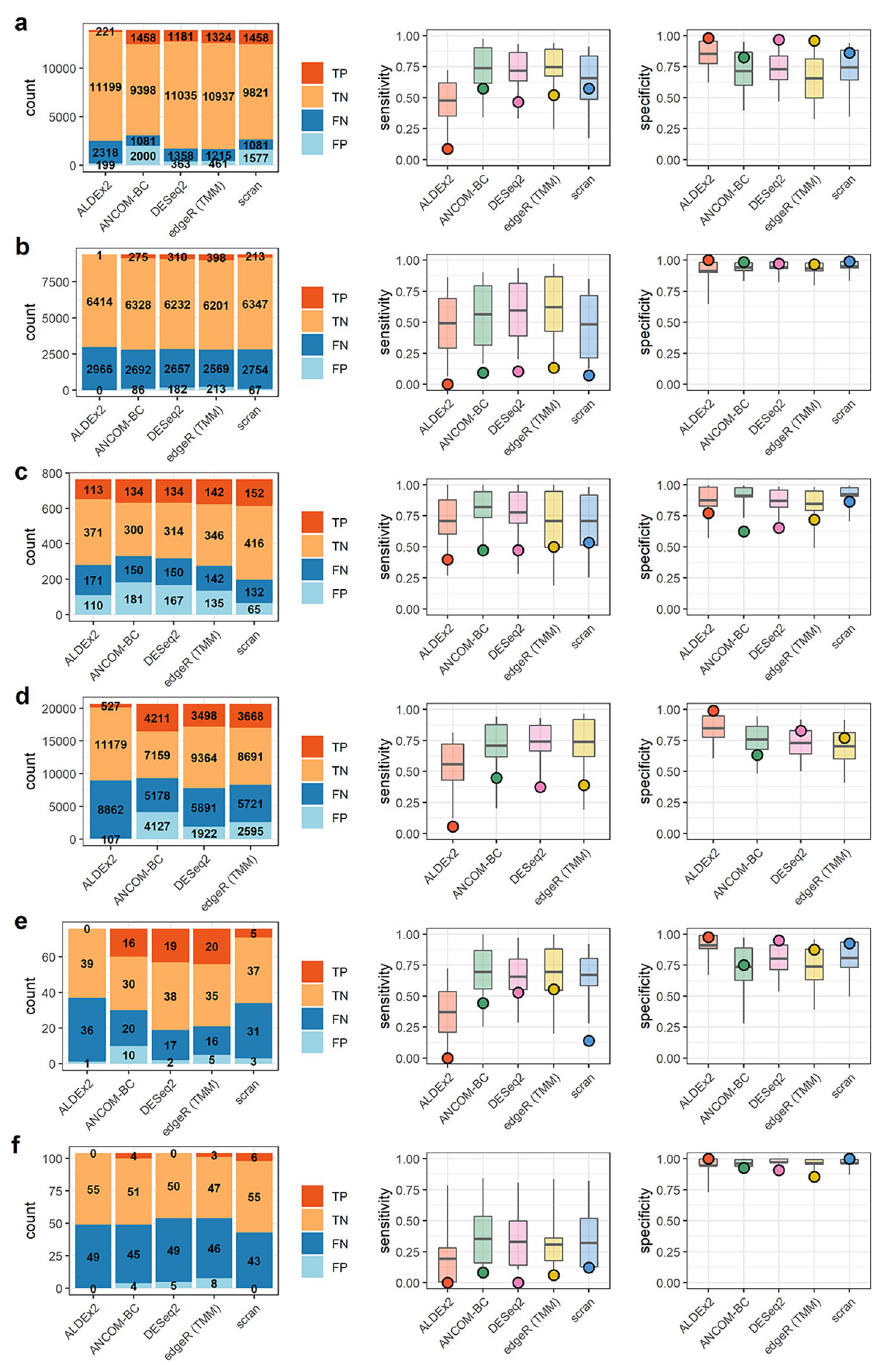
Fig 5. Results for real data sets 1–6. Results summaries for a) Hagai et al. b) Hashimshony et al. c) Song et al. d) Monaco et al. e) Vieira-Silva et al. f) Barlow et al. Barplots on the left indicate counts of true and false positives (TP, FP) and true and false negatives (TN, FN). Boxplots on the right indicate the 50% (box) and 90% (line) intervals of prediction and points, the observed values of either sensitivity or specificity.